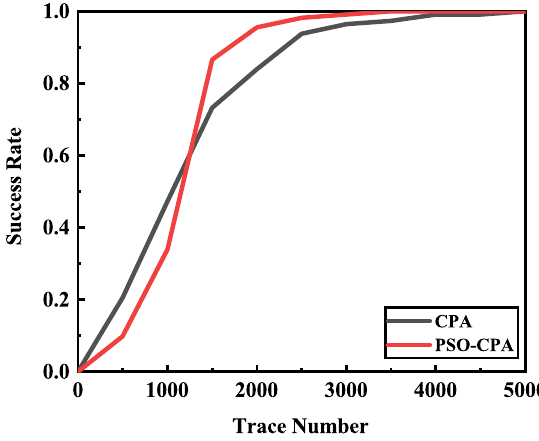
Figure 12. Success rate of different